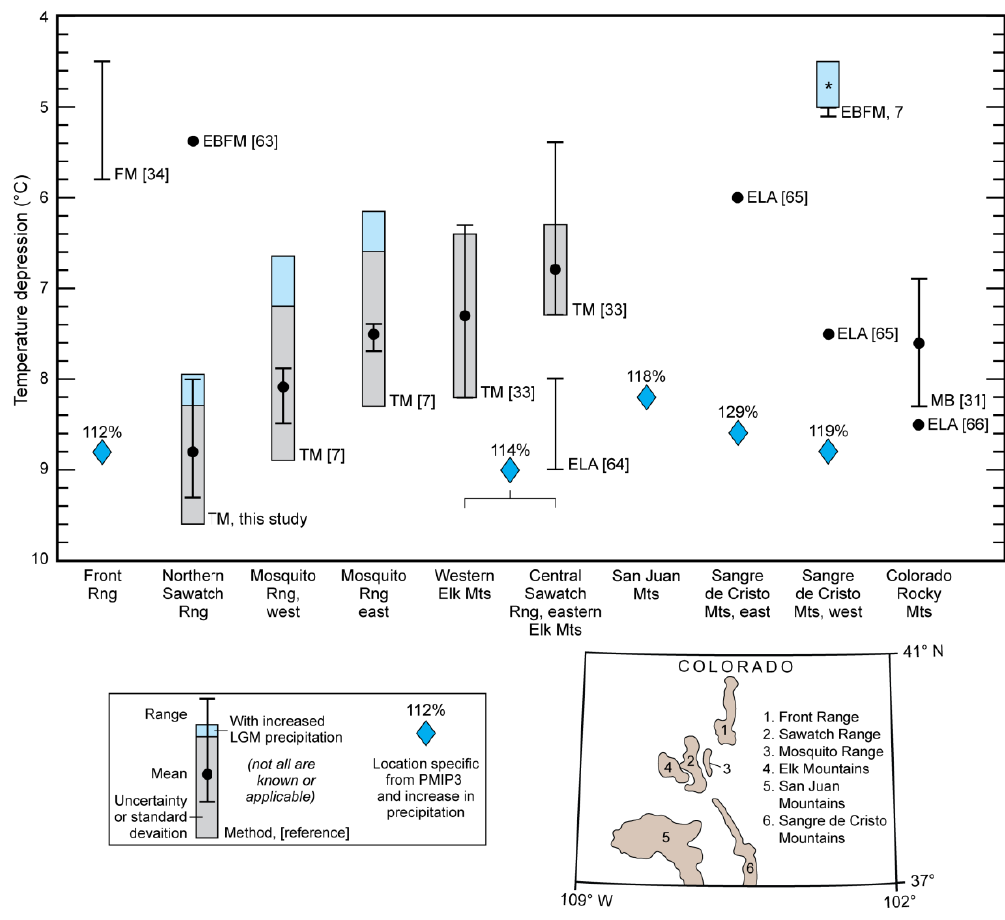
Figure 8. Derived estimates of LGM temperature depression in Colorado assuming no change in precipitation. Locations are arranged left-to-right roughly north (east) to south (west) according to the mean latitude of the glacier groups. Blue rectangles indicate temperature depression with 10 cm increase in precipitation; asterisk indicates 10% increase. Blue diamonds are location specific values from a PMIP3 ensemble [26]. Methodology: TM = temperature-index modeling, ELA = climatic interpretation at glacier equilibrium-line altitudes; FM = glacial flow modeling; EBFM coupled energy-balance and glacial flow modeling. Map inset shows the location of individual ranges in